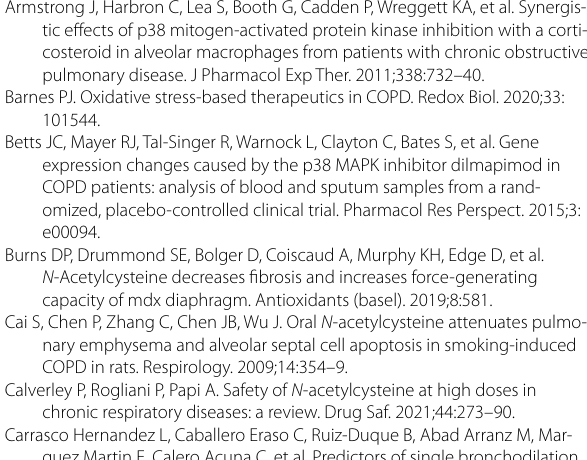
Additional file 1: Table S1. Clinical and pulmonary function characteris- tics of all subjects. Table S2 Silent sequence . Table S3 Primer sequences for RT-qPCR.